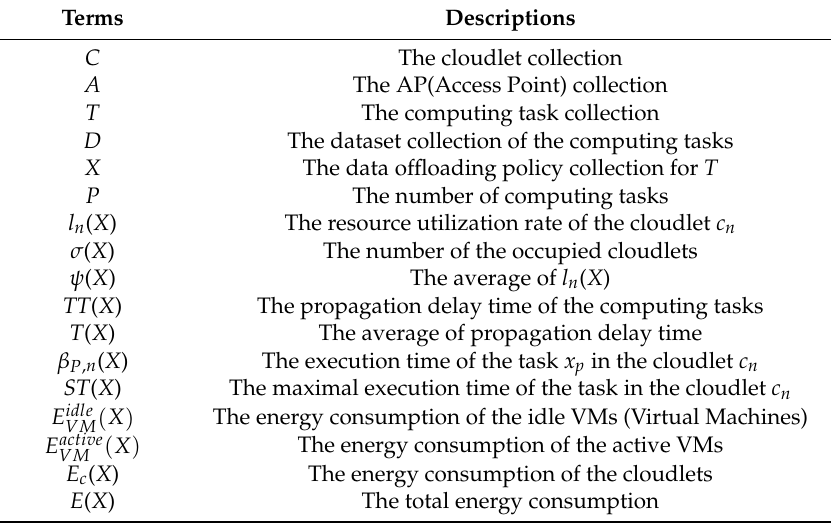
Table 1. Key notations and